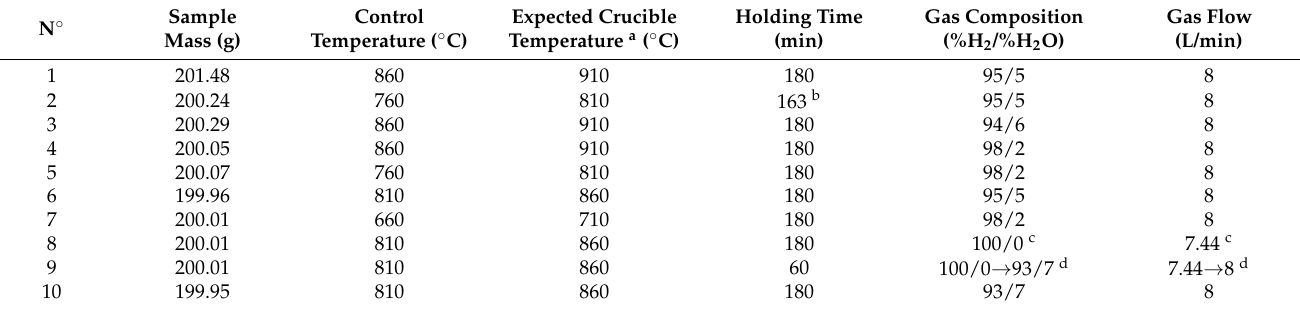
Table 2. Experimental parameters for this